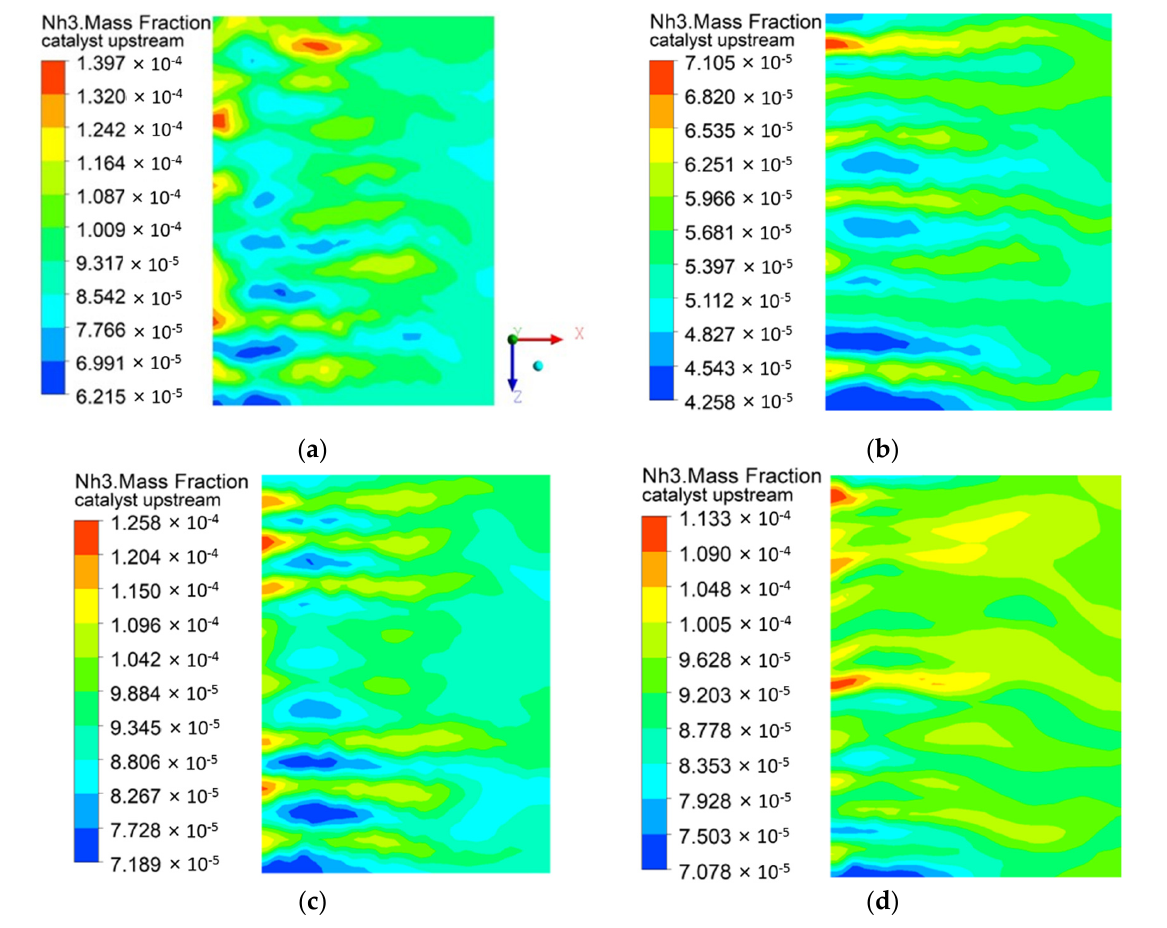
Figure 7. Contours of the ammonia mass concentration field distribution in the upstream section of the catalyst inlet corresponding to the different schemes: ( a ) Scheme 4.1; ( b ) Scheme 4.2; ( c ) Scheme 4.3; ( d ) Scheme 4.4. Table 4. Summary of C V values of the ammonia mass concentration field distribution in the up- stream section of the catalyst inlet corresponding to the different schemes.